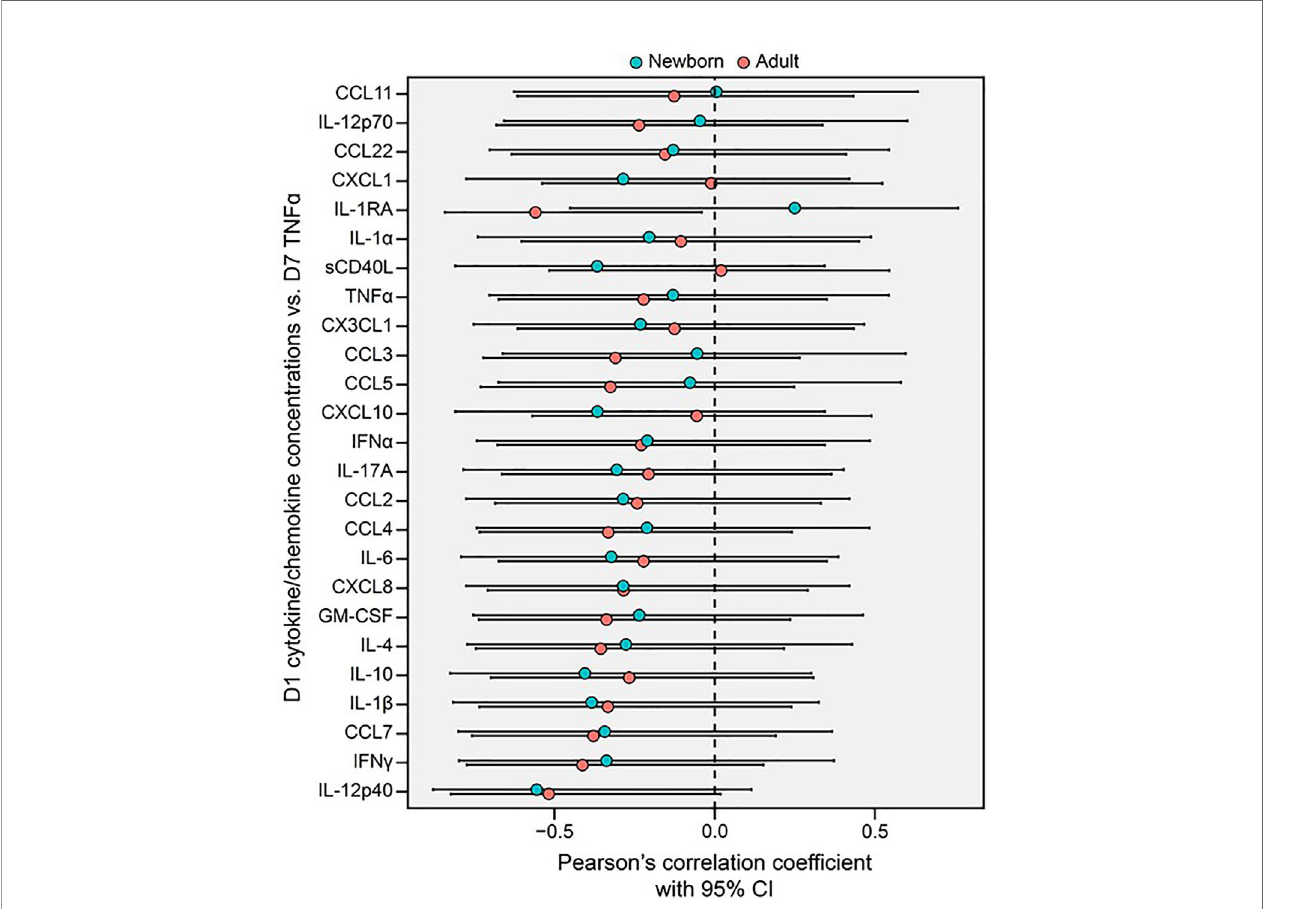
FIGURE 6 | Primary BCG-induced cytokine/chemokine concentrations (Day 1, D1) of human monocytes inversely correlate with their trained TNF cytokine concentrations (Day 7, D7) in newborns and adults. A Forest plot depicts pairwise comparisons between newborn and adult D1 cytokine/chemokine vs. D7 TNF correlations. Correlations between the cytokine and chemokine data depicted in Figures 3 , 5 were quanti fi ed using Pearson ’ s coef fi cient. Error bars represent the associated 95%